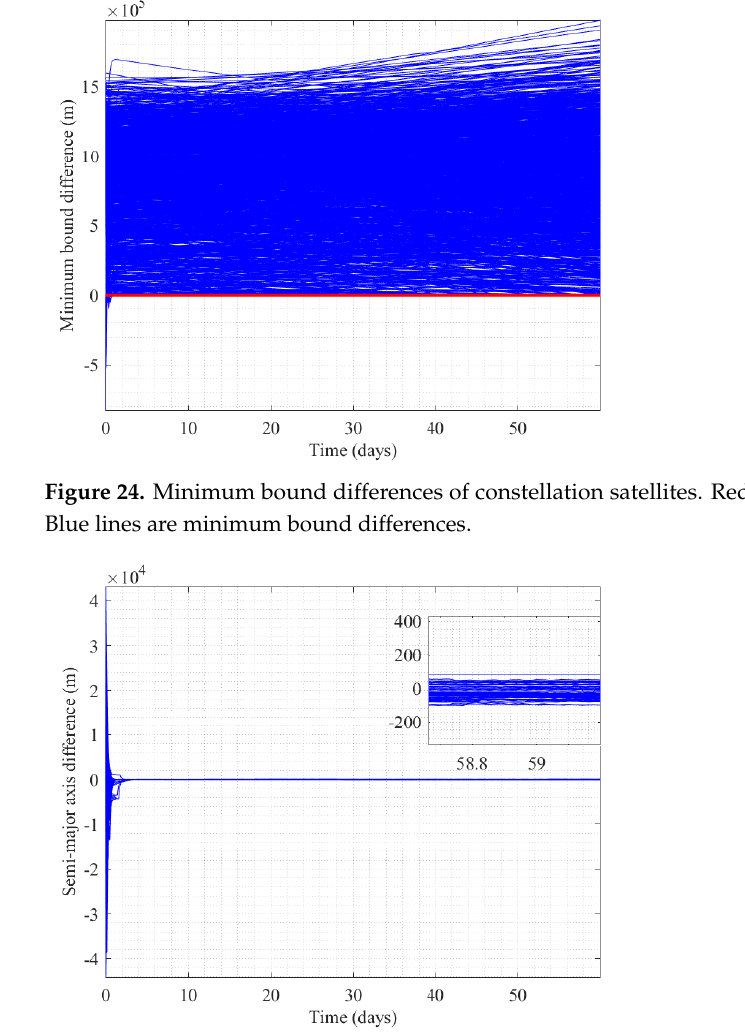
Figure 25. Semi-major axis differences of constellation